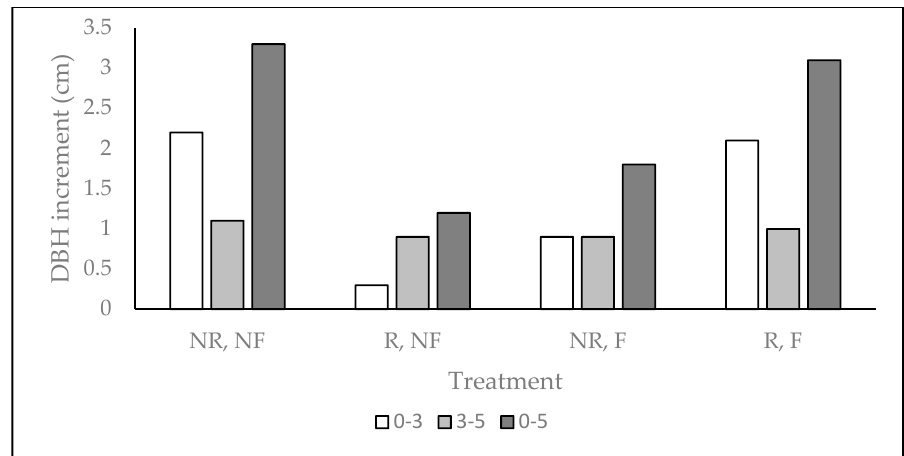
Figure 4. Longleaf pine (stand age 34–39) diameter at 137 cm above groundline (dbh) increment by treatment 0 to 3 years after treatment (YAT), 3 to 5 YAT and over the entire five-year study period [15].